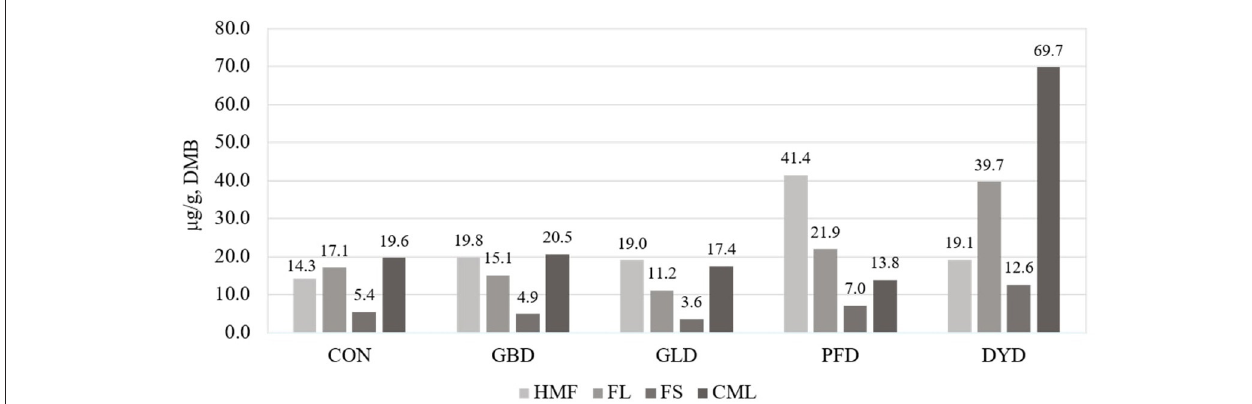
FIGURE 1 | Presence of Maillard reaction products (MRPs) in canine diets containing legumes or yeast as the primary protein source. DMB, Dry matter basis; CON, Poultry by-product meal control; GBD, Garbanzo bean; GLD, Green lentil; PFD, Peanut flour; DYD, Dried yeast; HMF, Hydroxymethylfurfural; FL, Fructoselysine; FS, Furosine; CML, Carboxymethyllysine. Statistical analysis could not performed due to use of technical replicates.